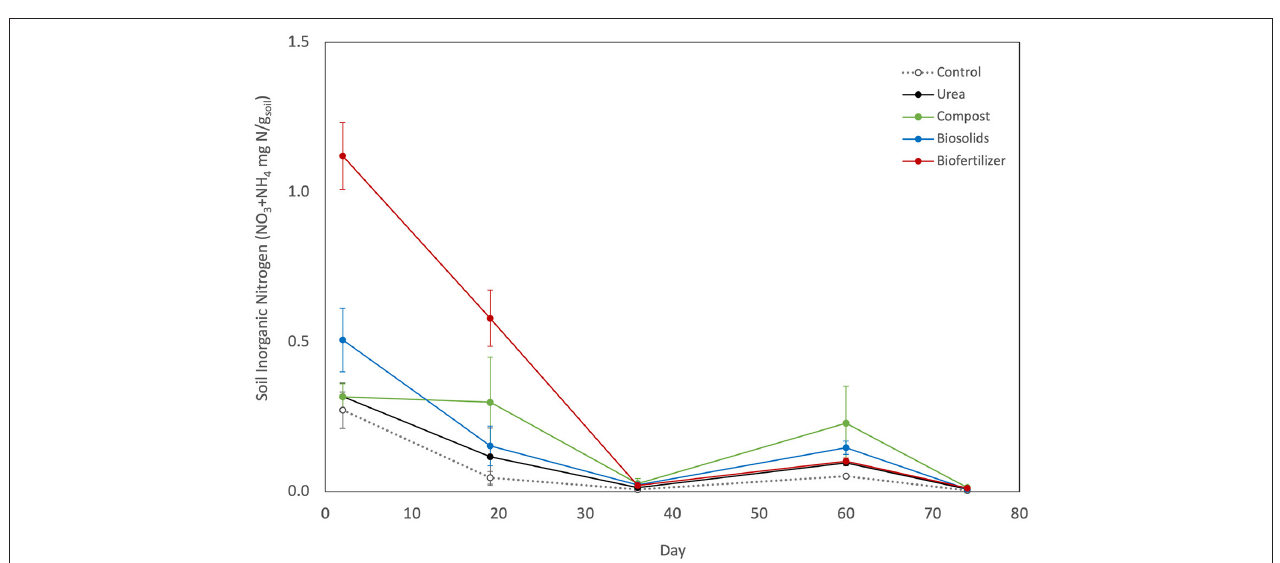
FIGURE 4 | Soil total inorganic N (NO 3 + NH 4 ) pools within the first two crop